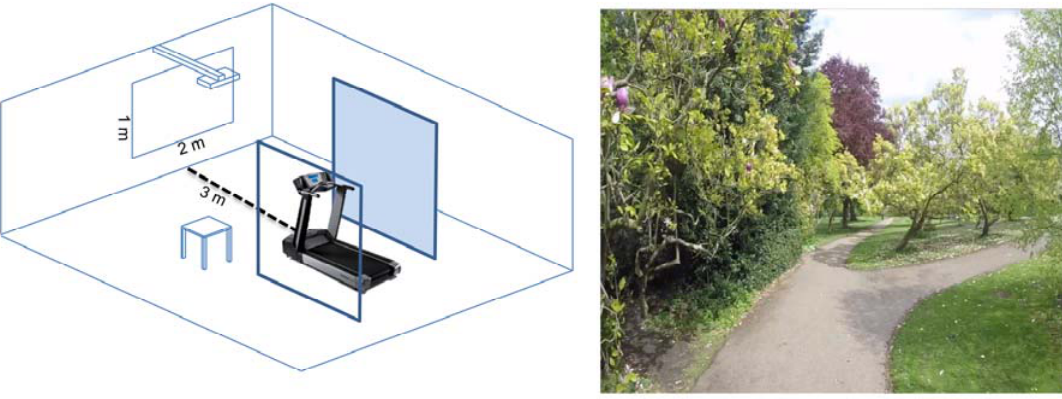
Figure 1. Left: The experimental setting, the treadmill is 3 m from the wall with projecting media and two partitions stand next to the treadmill [6]. The projected screen is 2 × 1 m; Right: The one single frame from the dynamic image condition used throughout the whole twenty ‐ minute.